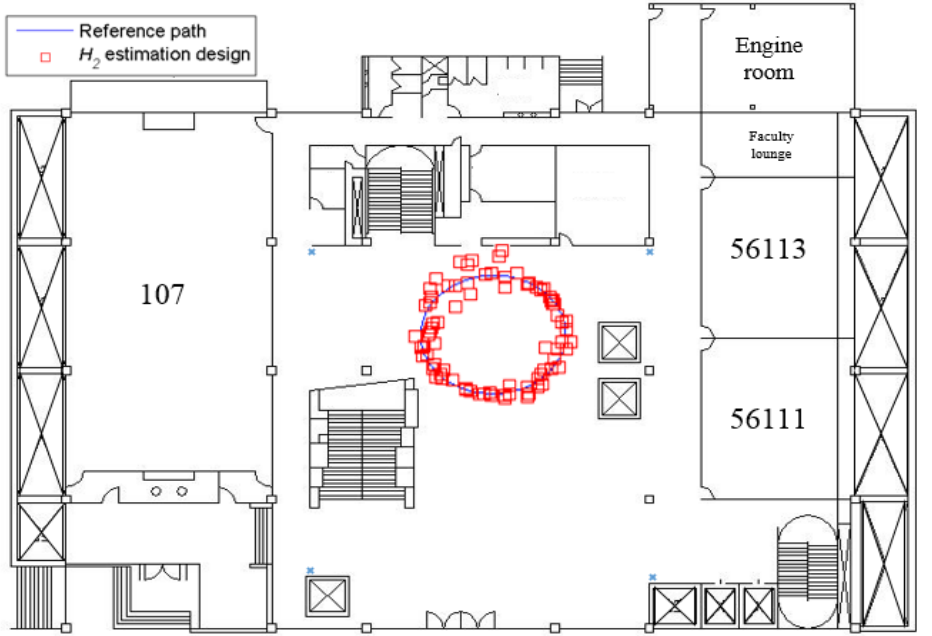
Figure 16. The indoor positioning result of the proposed H 2 estimation design (real test).